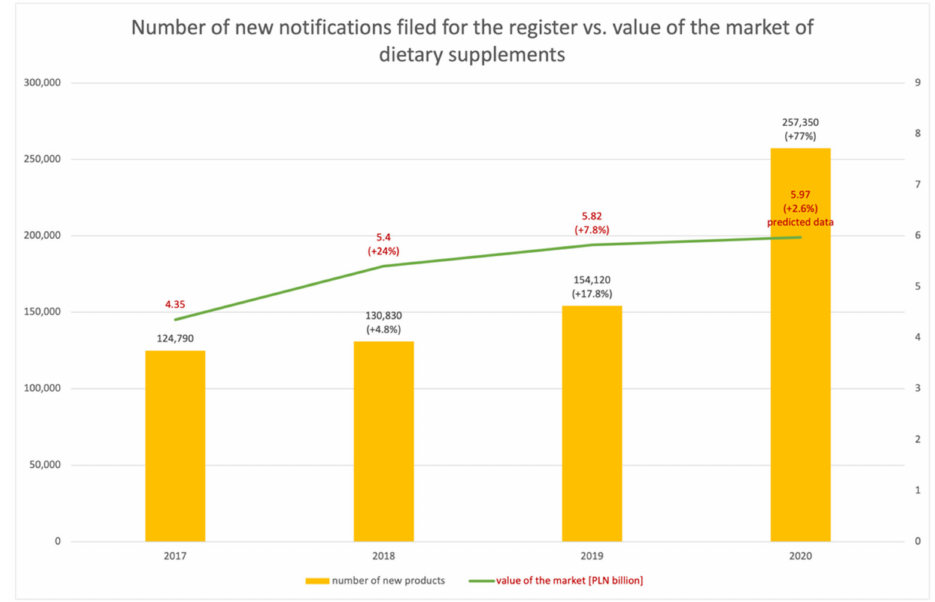
Figure 3. Number of new entries into the register of functional foods against the value of the market of dietary supplements in